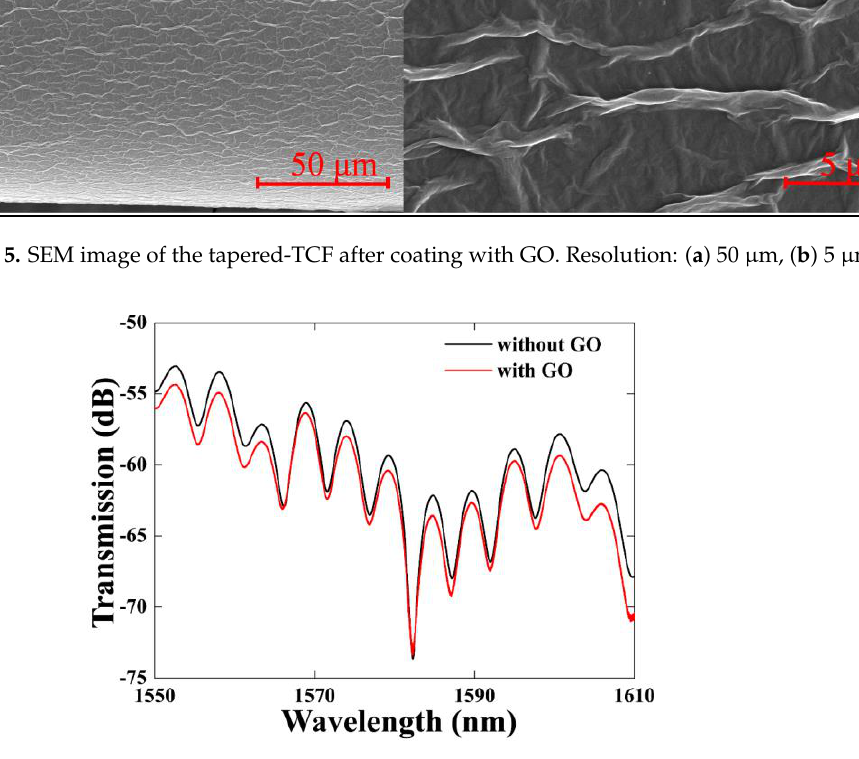
Figure 6. Transmission spectrum before and after coating with graphene oxide.